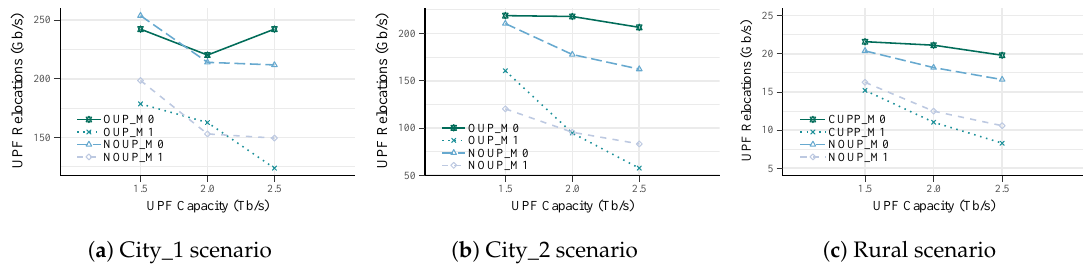
Figure 12. UPF Relocation Rate vs. capacity for services without low